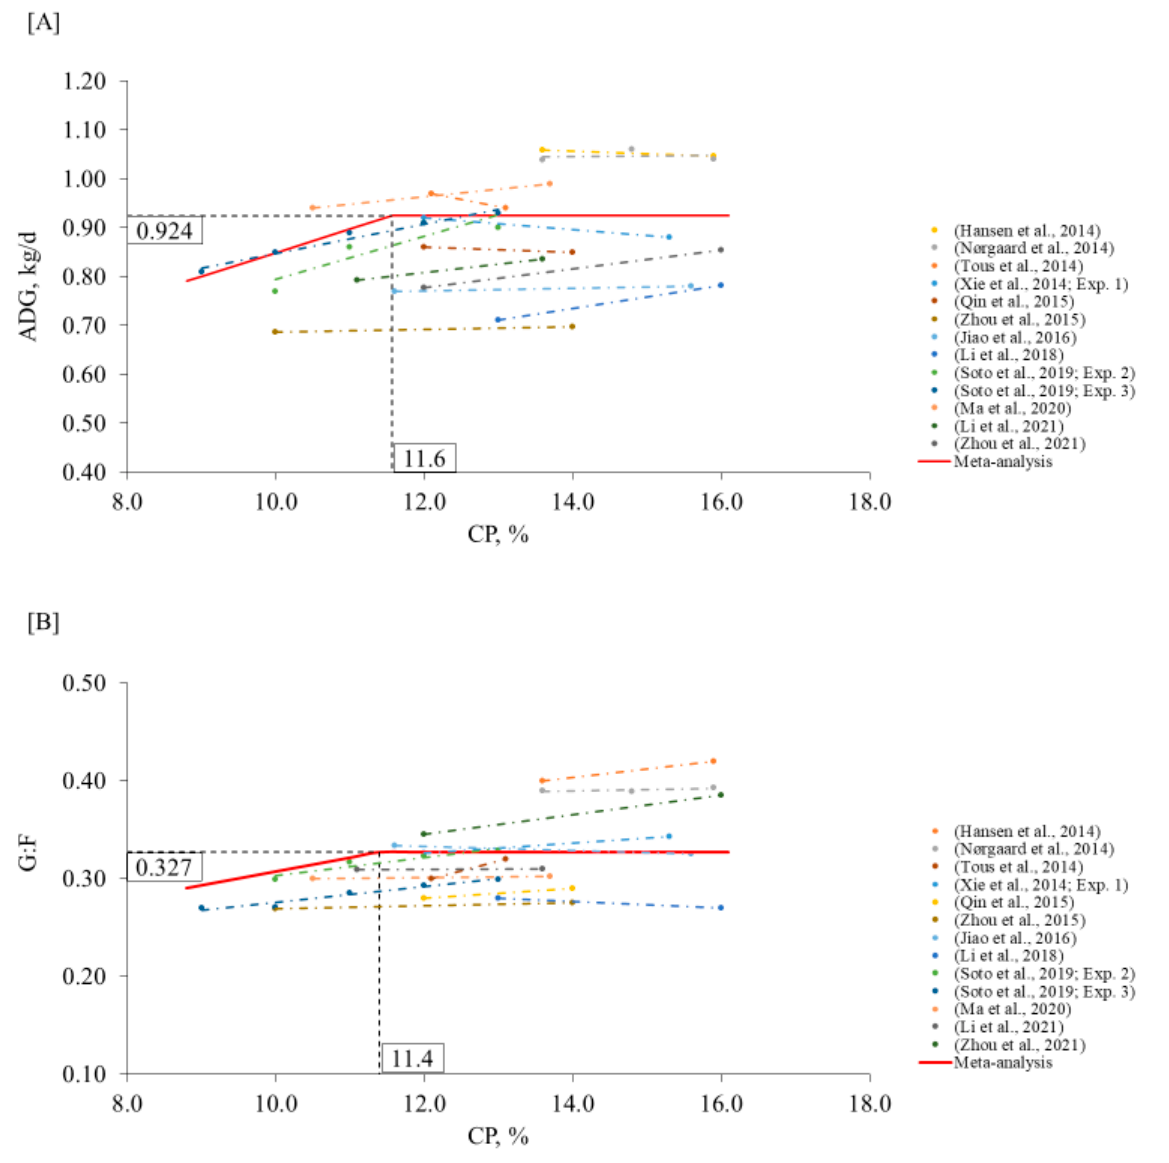
Figure 5. Changes in ADG ( A ) and G:F ( B ) in response to dietary CP in the finishing phase using a broken ‐ line analysis. The equation for ADG was ADG = 0.924 – 0.048 × zl (R 2 = 0.98) and the break ‐